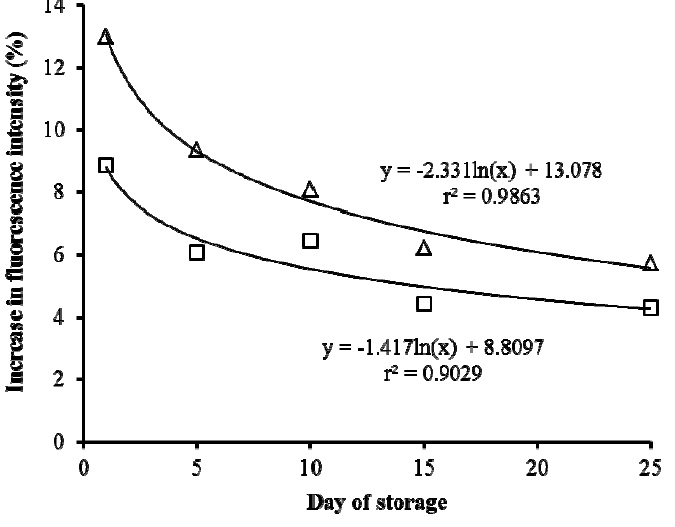
Figure 8. The effect of pHEMA on storability of biosensor, with the test on Cu 5